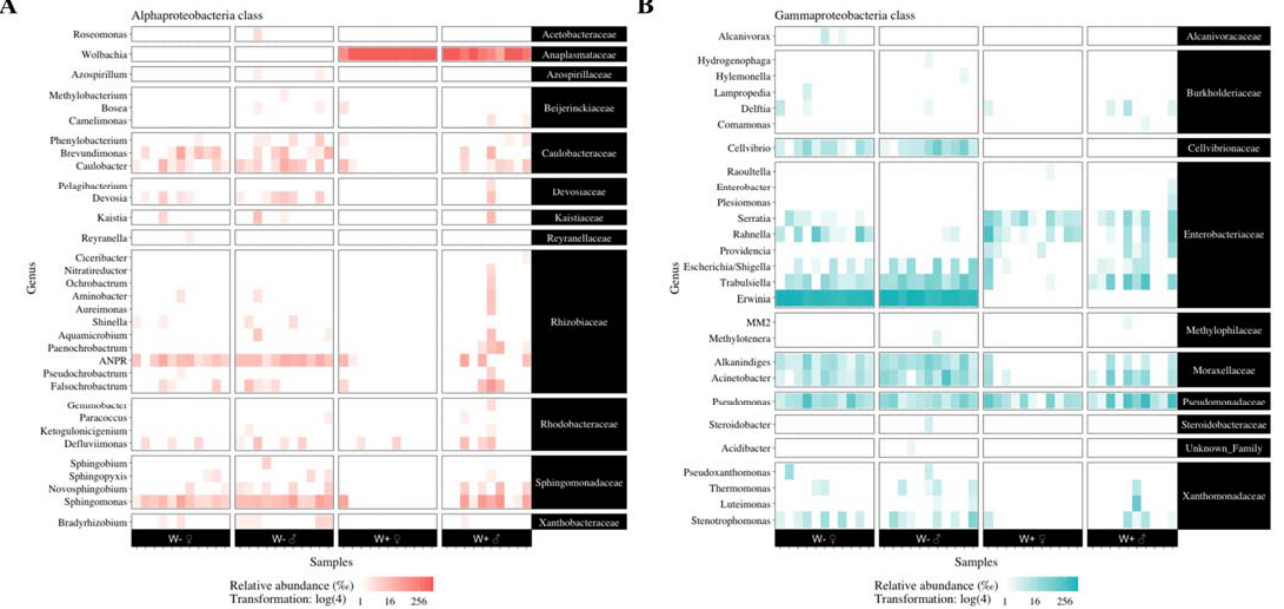
Figure 3. Bacterial genera from the α - ( A ) and γ -Proteobacteria ( B ) present in Wolbachia -free (“W − ”) and infected (“W+”) lines. The relative abundance is expressed per mille and was log-transformed. ANPR = Allorhizobium – Neorhizobium – Pararhizobium – Rhizobium .